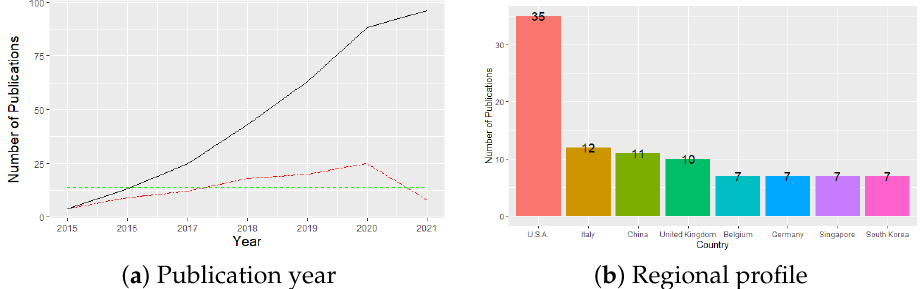
Figure 2. Systematic review analysis of target research articles.